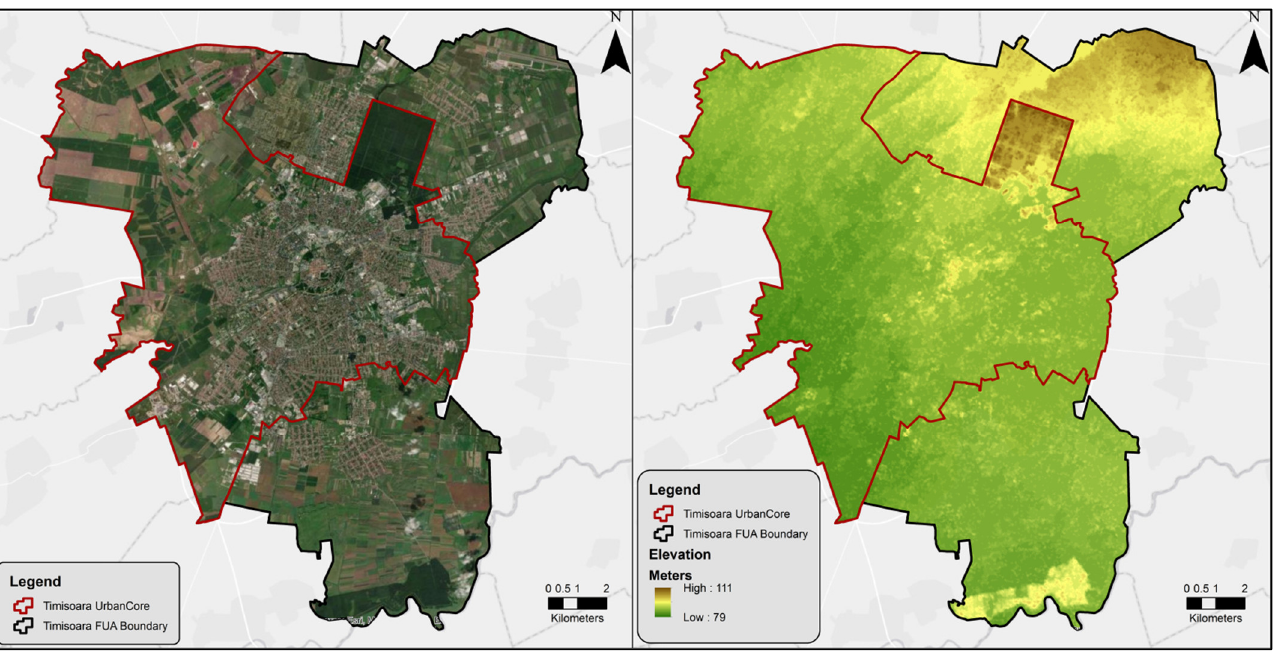
Figure 4. Satellite imagery- true color ( left ) and digital elevation model ( right ) for the 2nd case study: Timișoara.